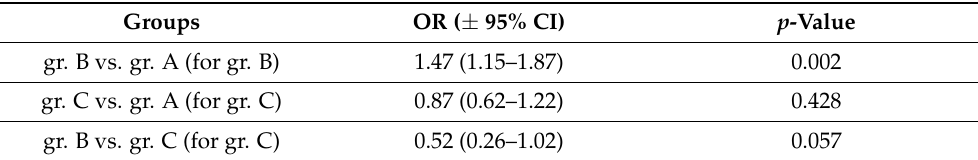
Table 3. Logistic regression analysis of membership in selected groups of COVID-19 patients as predictors of patient’s